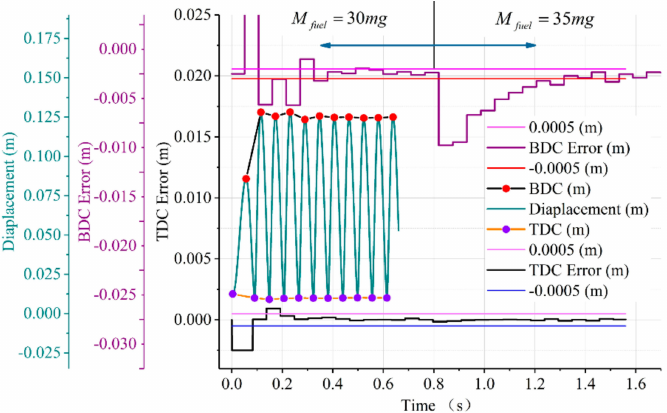
Figure 13. Dead center errors of